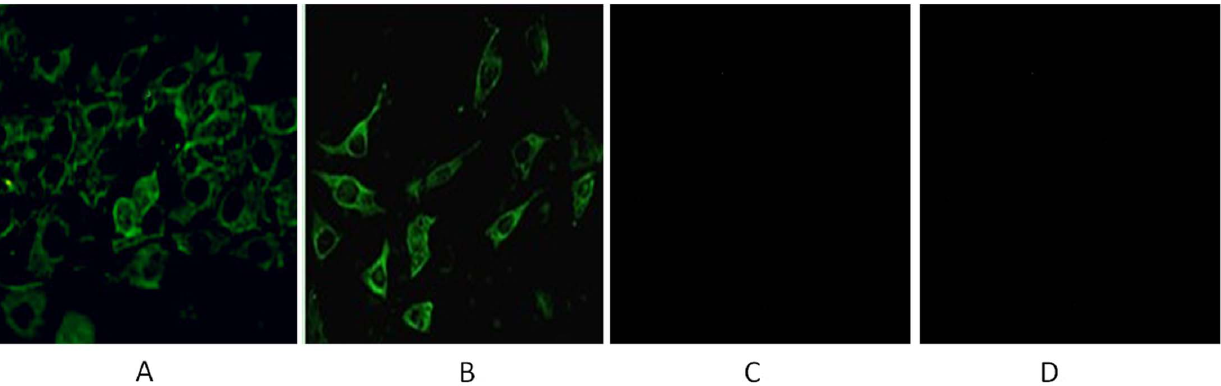
Figure 2. Transient expression of Mx and NA gene in transfected NIH 3T3 cells by IFA. A: The NIH 3T3 cells transfected with pVITRO2-Mx- NA (Mx antibody); B: The NIH 3T3 cells transfected with pVITRO2-Mx-NA (NA antibody). C: The NIH 3T3 cells transfected with pVITRO2; D : NIH 3T3 cells.